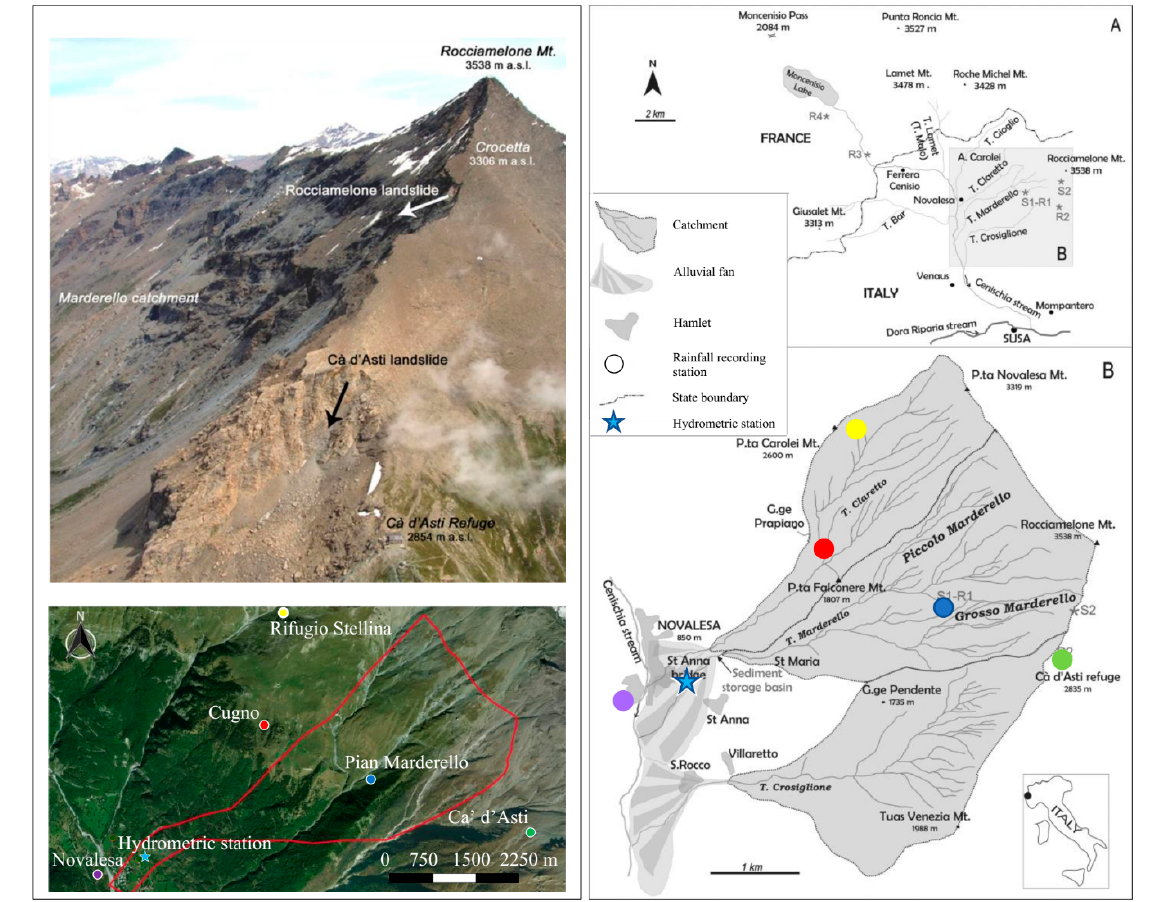
Figure 1. Map of the Marderello site; Pluviometric and Hydrometric Stations location.